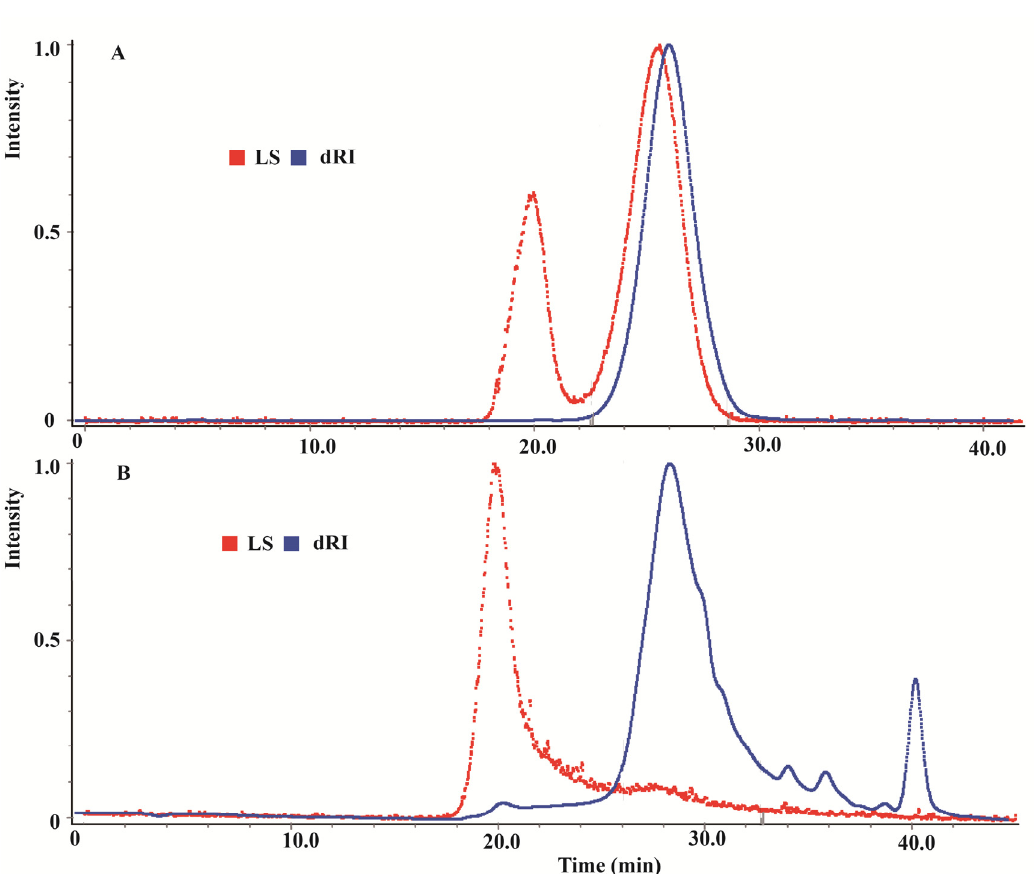
Figure 1. Light scattering (LS) and differential refractometer (dRI) gel permeation chromatogram of (1,3)(1,4)- β -glucan standard ( A ) and CMPE ( B